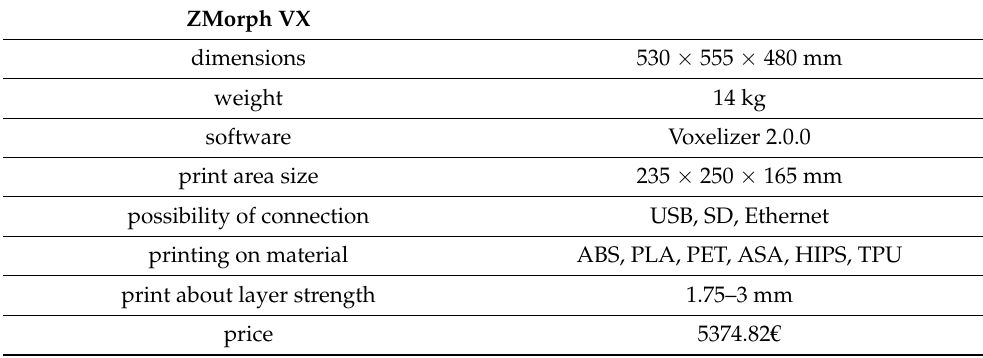
Table 2. Basic specifications of the 3D printer ZMorph